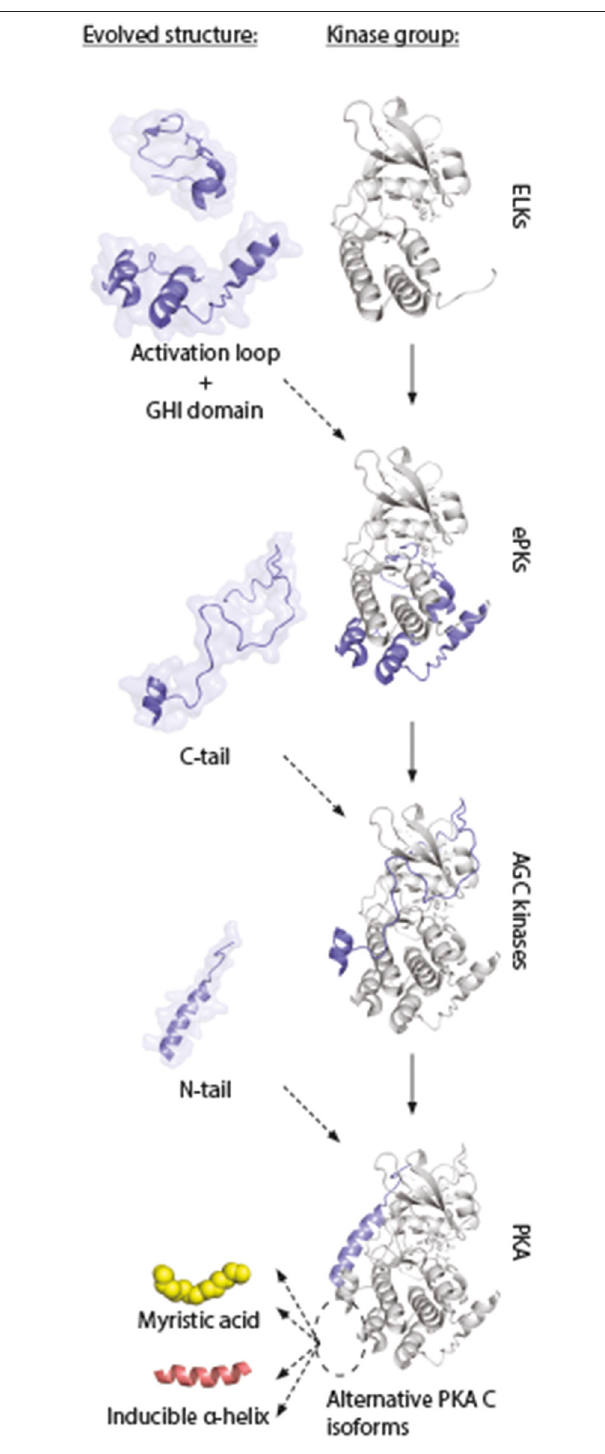
FIGURE 7 | Model of evolution of PKA C subunits. The catalytic core is a conserved feature of the eukaryotic-like kinases (ELKs). The ePKs differ from ELKs through the attainment of the activation loop, typically involving a phosphorylatable Thr which can regulate the catalytic core into active/inactive conformations, and the G, H, and I helices (“GHI domain”), serving as docking